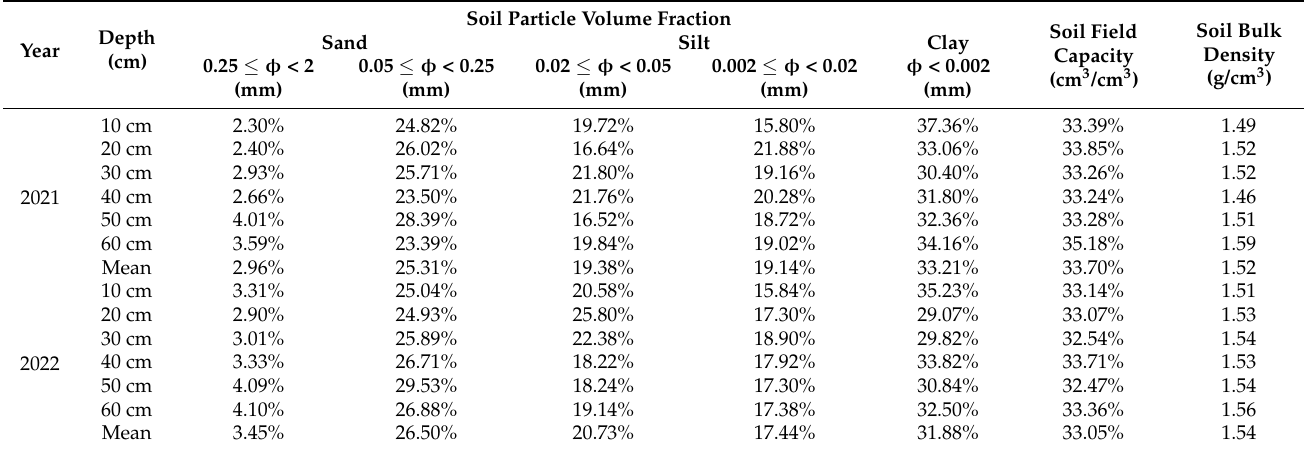
Table 2. Mechanical composition of the soil at different